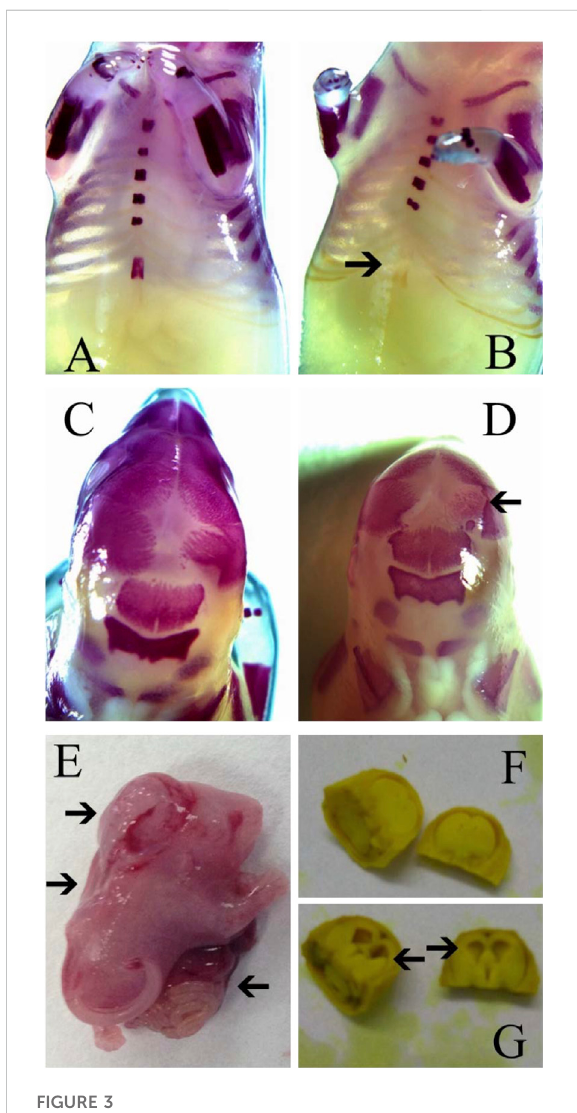
FIGURE 3 Typical malformations observed in fetuses of rats in this study. (A) Normal sternum; (B) Sternal defect; (C) Normal skull; (D) Skull ossi fi cation retardation; (E) Encephalocele, spina bi fi da and abdominal fi ssure; (F) Normal lateral ventricle; (G) Lateral ventricle enlargement. Arrow indicates